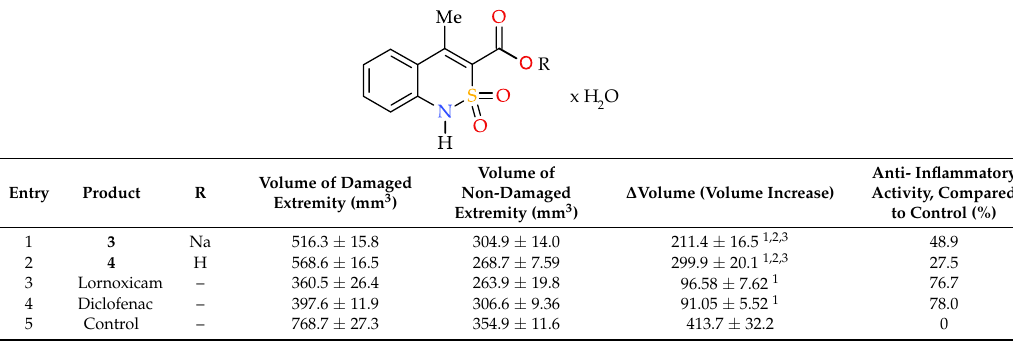
Table 1. The Anti-Inflammatory Activity of Sodium Salt 3 , Acid 4 , and Reference Drugs.